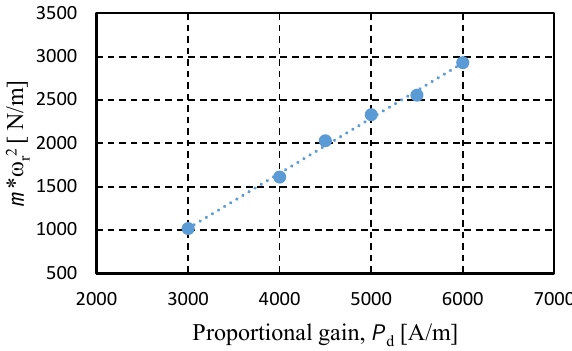
Figure 7. Relationship between stiffness of the system to the proportional gain. Dots: data points and dotted line: linear regression line.